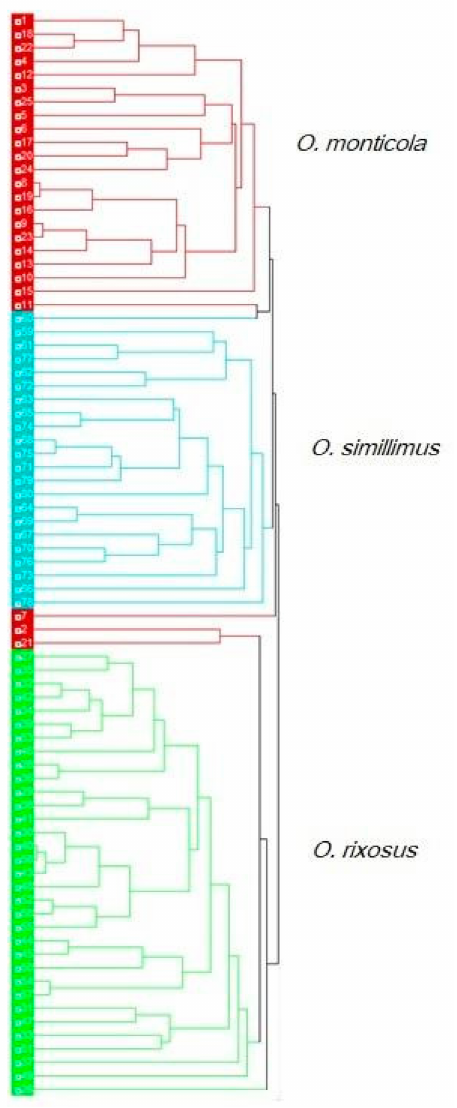
Figure 7. UPGMA hierarchical analysis generated from the 7 first principal components of shape variables describing the head of each individual. Table 2. Mahalanobis distances and statistical significance among three Odontomachus ants based on normalized Fourier coefficients. Species Head